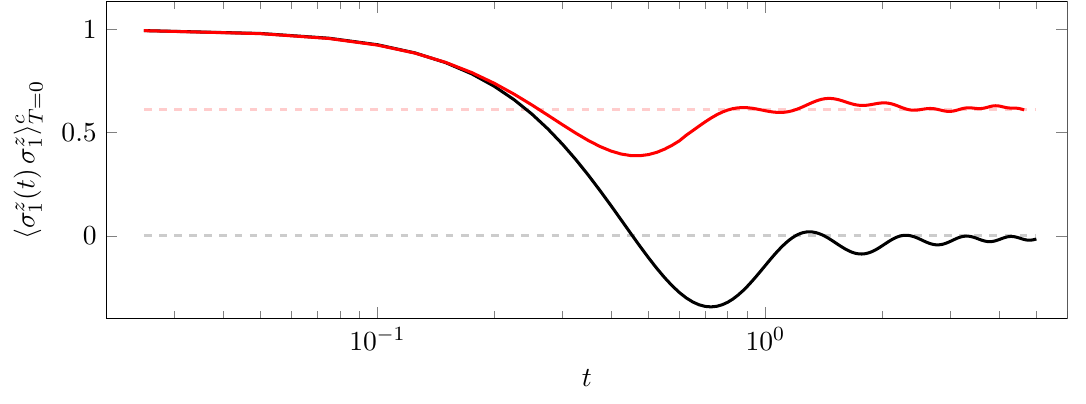
( t ) σ z 〉 c vs. time t , T = 0 1 1